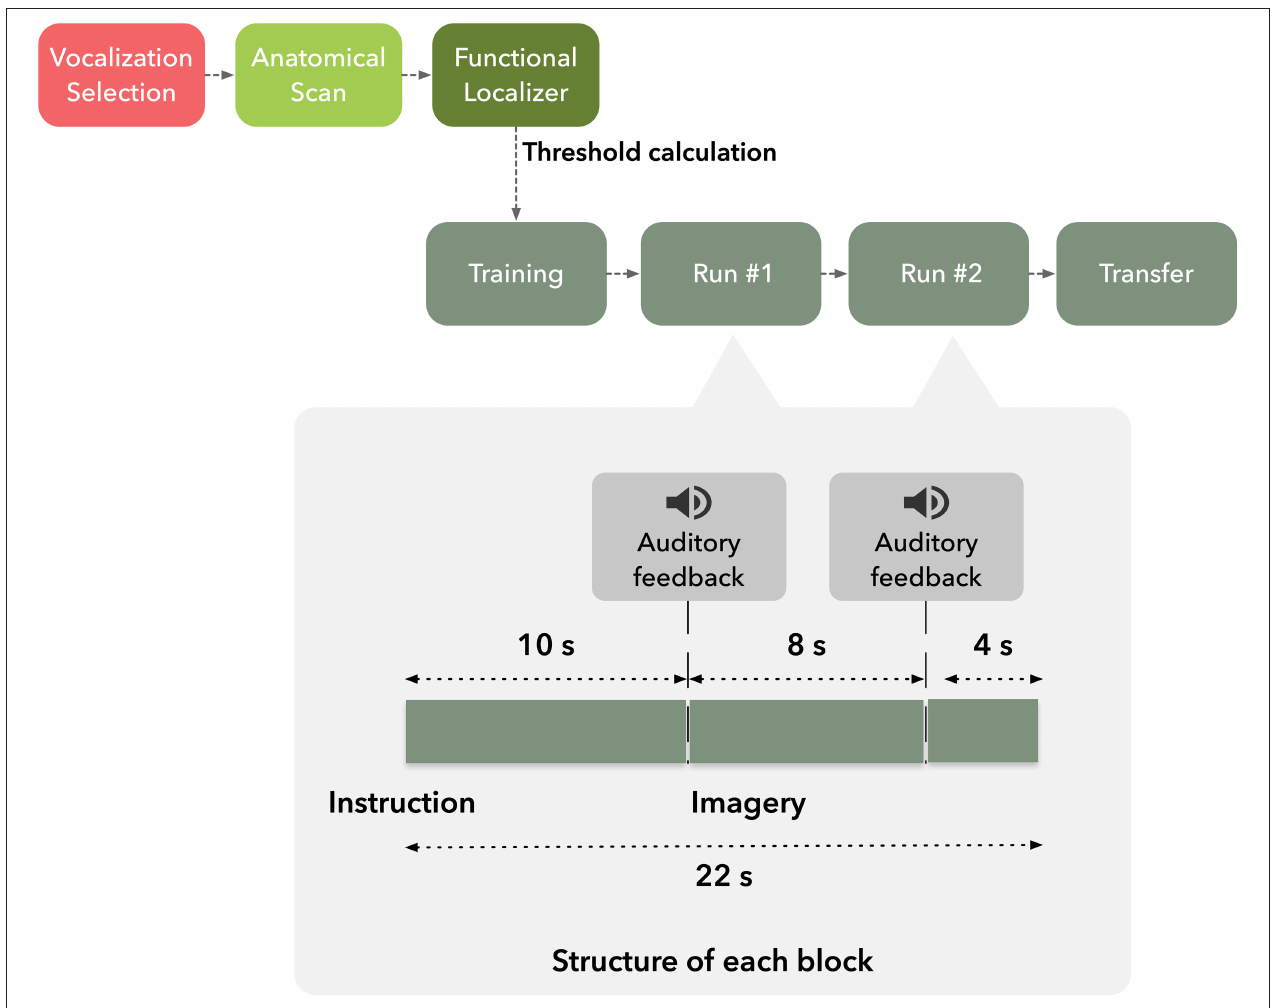
FIGURE 1 | Graphical representation of the timeline of the